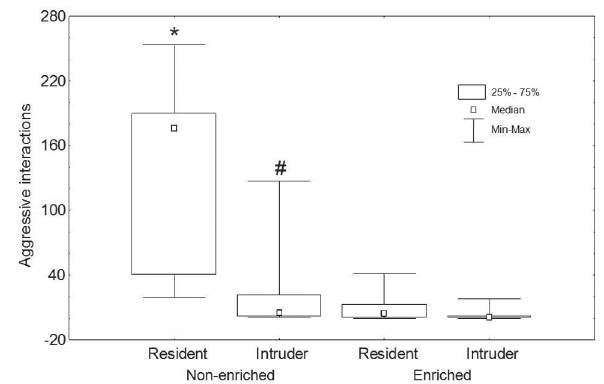
Fig. 1. Effect of environmental enrichment on aggressive interactions in pairs of pearl cichlid Geophagus brasiliensis . Aggression was studied in the resident fish’s territory. The graphic shows median, quartiles, and minimum and maximum values. * denotes statistical difference between values within a same enrichment condition (p < 0.05; Wilcoxon test) and between resident fish (p < 0.05; Mann-Whitney U test). # denotes statistical difference between value for intruder fish (p < 0.05; Mann-Whitney U